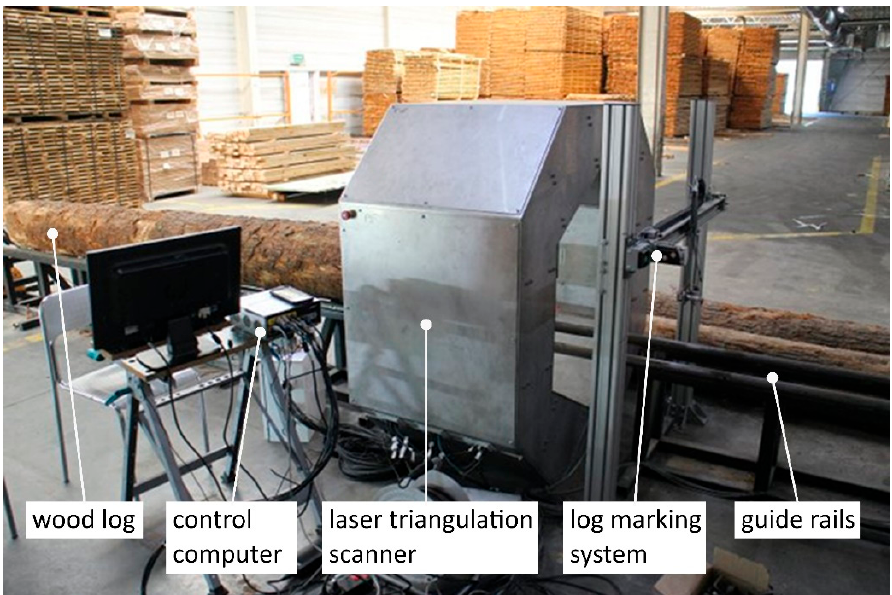
Figure 7. Log scanning system. In the picture the following elements of the system can be seen: scanned log placed on the conveyor, laser triangulation scanner, part of the log marking system, computer controlling the scanning process.